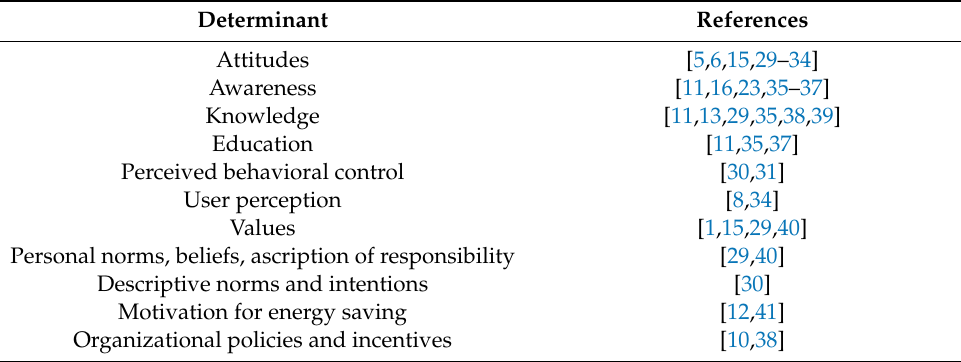
Table 3. Psychological and social determinants in